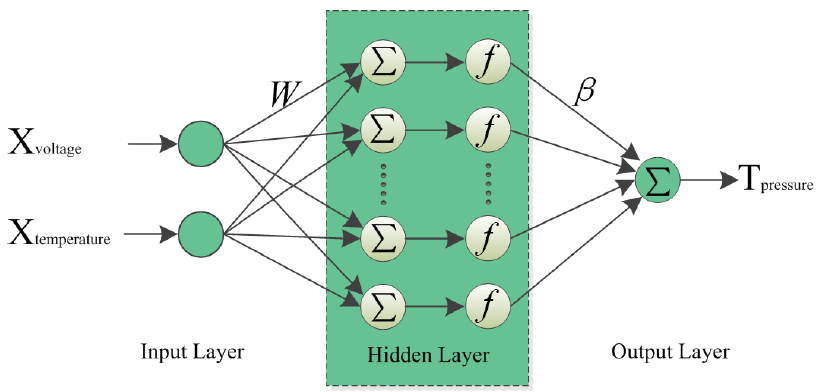
Figure 2. The structure of